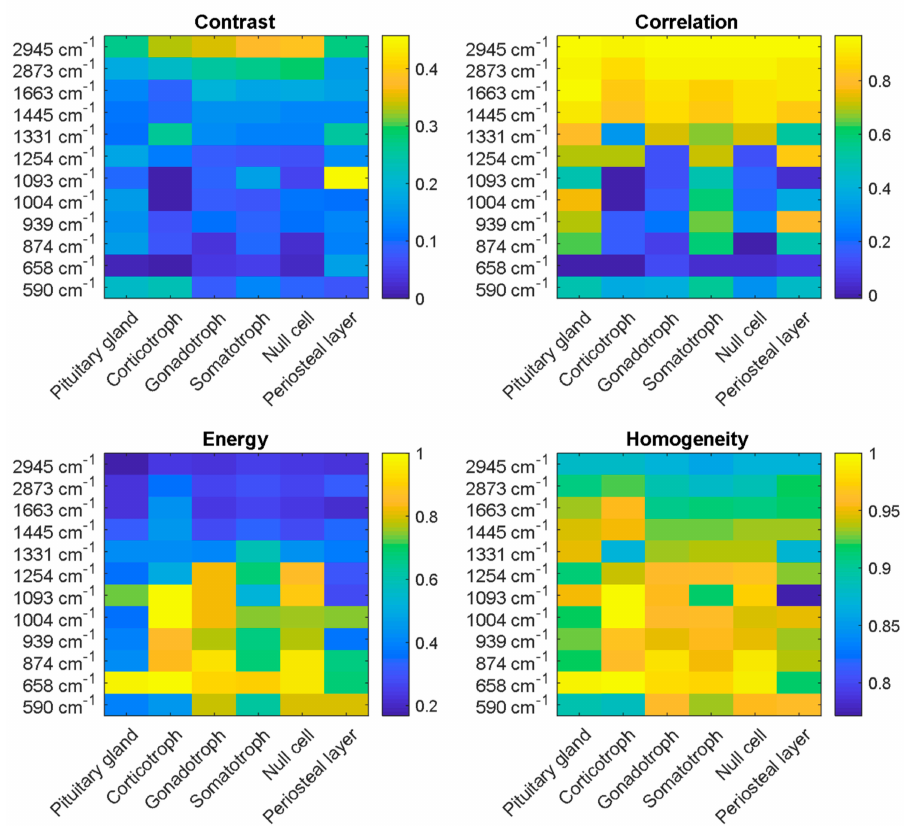
Figure 6. Texture analysis based on GLCM deriving the four statistical measures (contrast, correlation, energy and homogeneity) was applied to LSRM images at significant peaks determined by PCA.